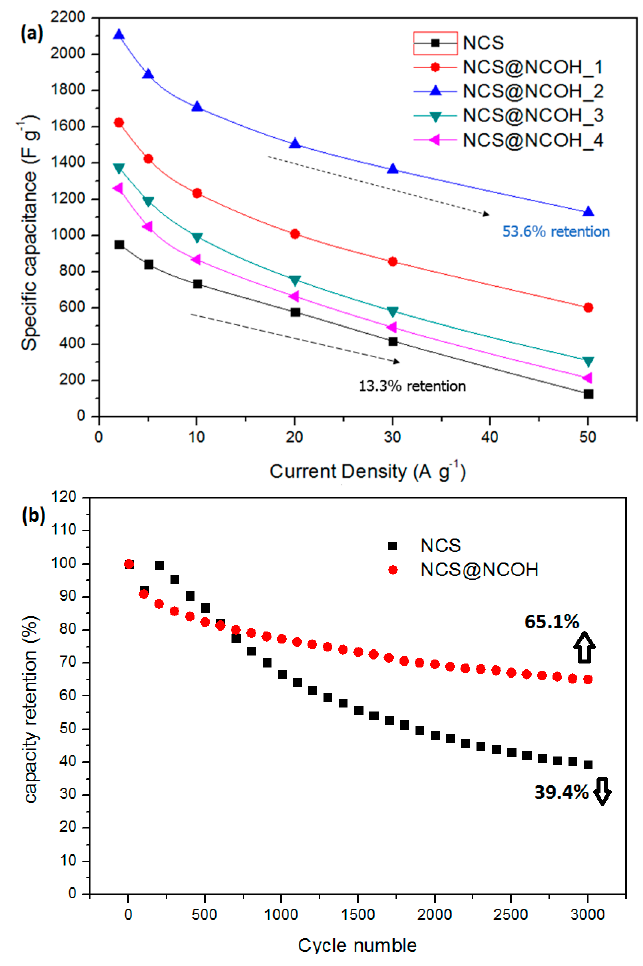
Figure 8. ( a ) Specific capacitance of NCS@NCOH core-shell nanotube array electrodes with different electrodeposition times and ( b ) cycling performance of NCS and NCS@NCOH at 50 A g − 1 for 3,000 cycles.